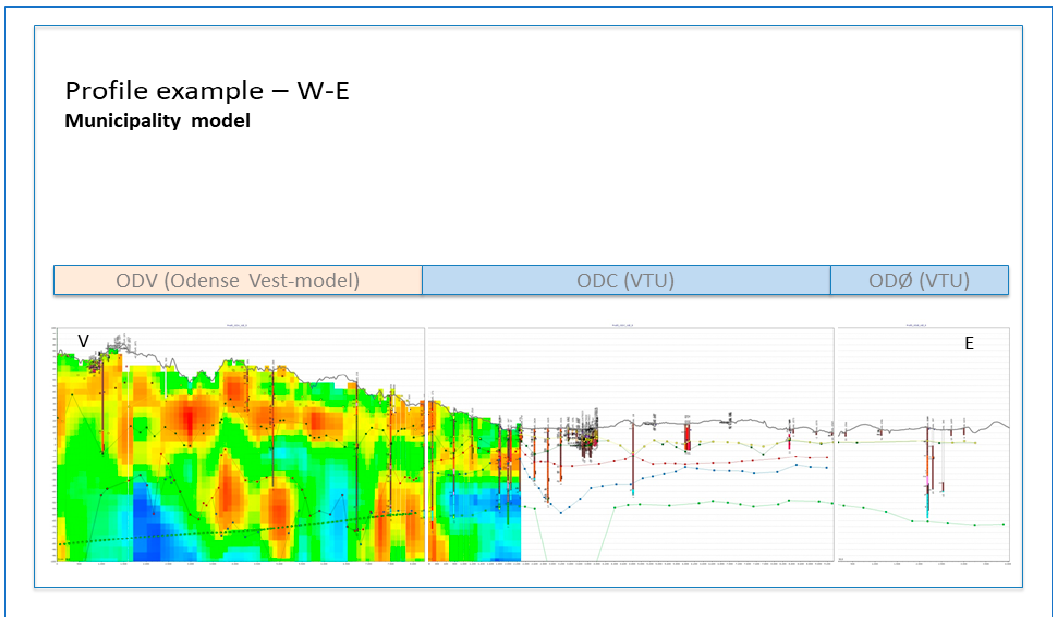
Figure 6. Variations in data density in the subsurface information in Municipality model on west–east profile [25,29]. The western side of the urban area is shown with a comprehensive groundwater mapping illustrated by the ‘colored’ results of the geophysical survey (Odense Vest model). The city center is located in the middle profile and has many shallow boreholes, and on the eastern side limited groundwater interests are illustrated by restricted data availability. Water 2020 , 12 , x FOR PEER REVIEW